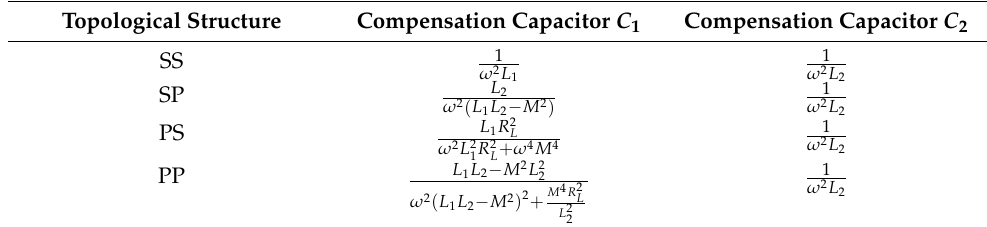
Table 3. Compensation capacitance of magnetically coupled resonant WPT. Topological